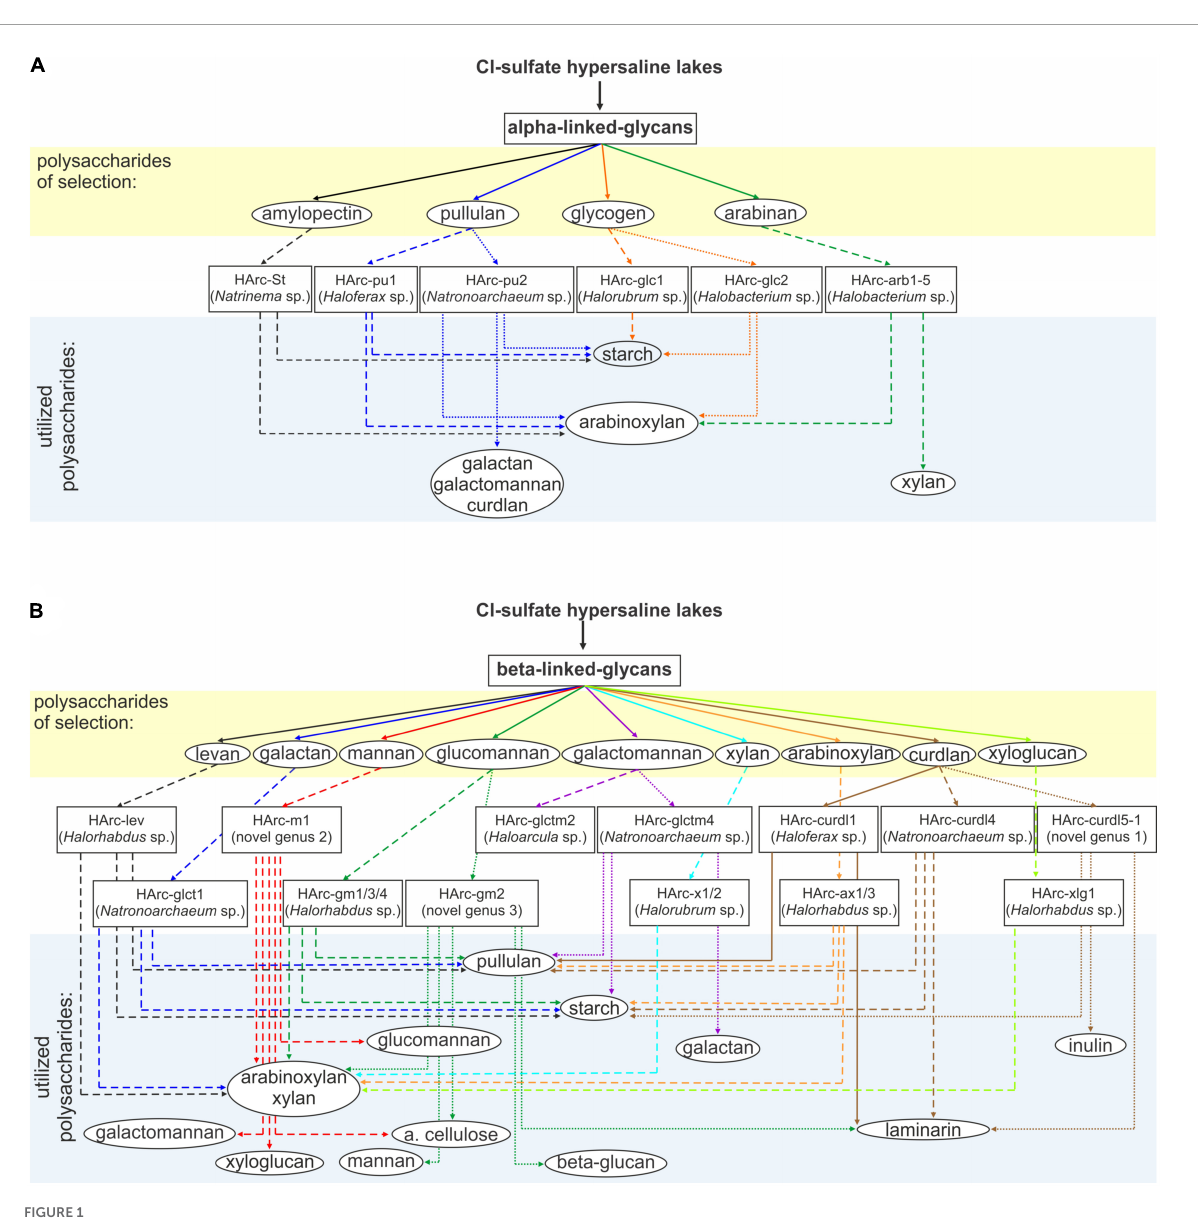
FIGURE1 Schematic representation of selective enrichments of haloarchaea from hypersaline salt lakes on (A) alpha-bonded and (B) beta-bonded polysaccharides. Assignment to the novel genus was based on protein sequence-based phylogenomic analysis and 16S rRNA gene sequence identity